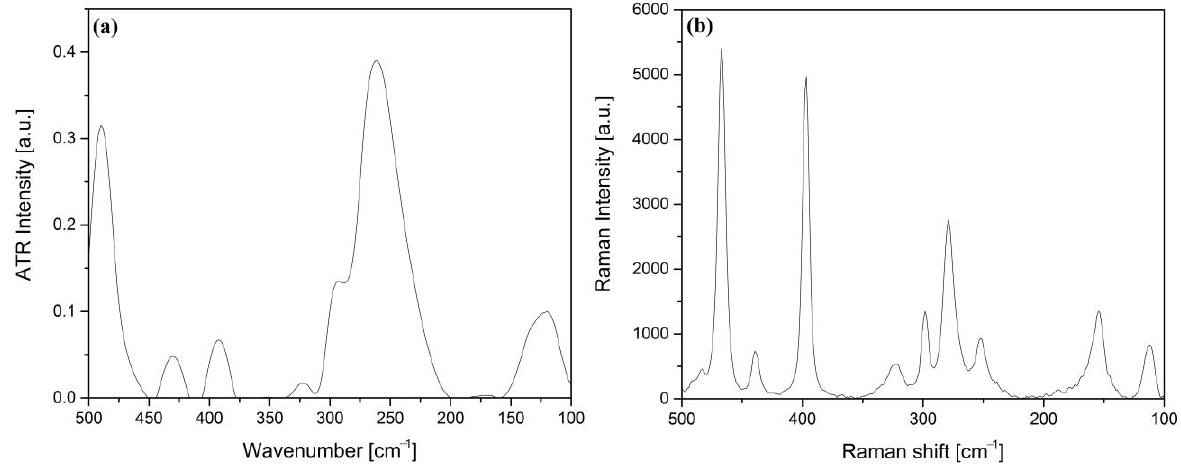
Figure 4. The far-IR (25 °C) and low- temperature Raman (785 nm excit., −150 °C) spectra between Figure 4. ( a ) The far-IR (25 ◦ C) and ( b )low-temperature Raman (785 nm excit., − 150 ◦ C) spectra 500 and 100 cm −1 . between 500 and 100 cm − 1